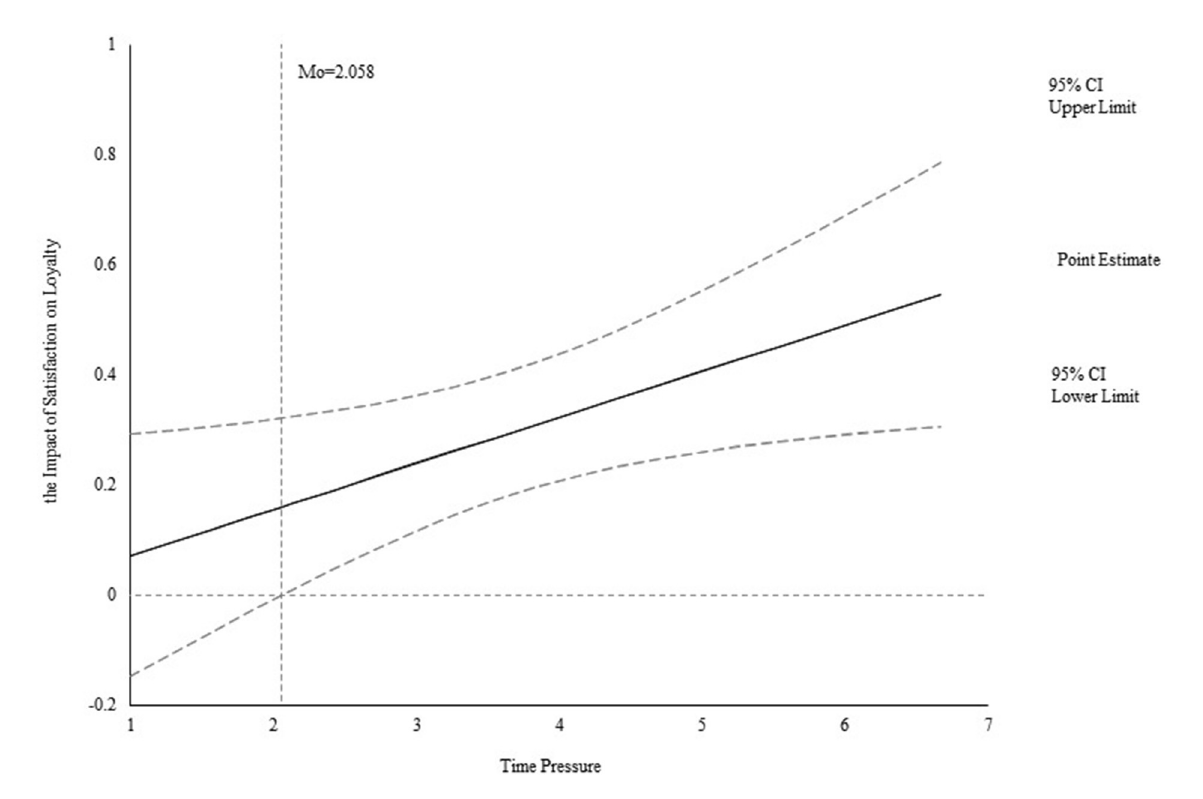
FIGURE4 Effect of time pressure on the relation between satisfaction and loyalty.